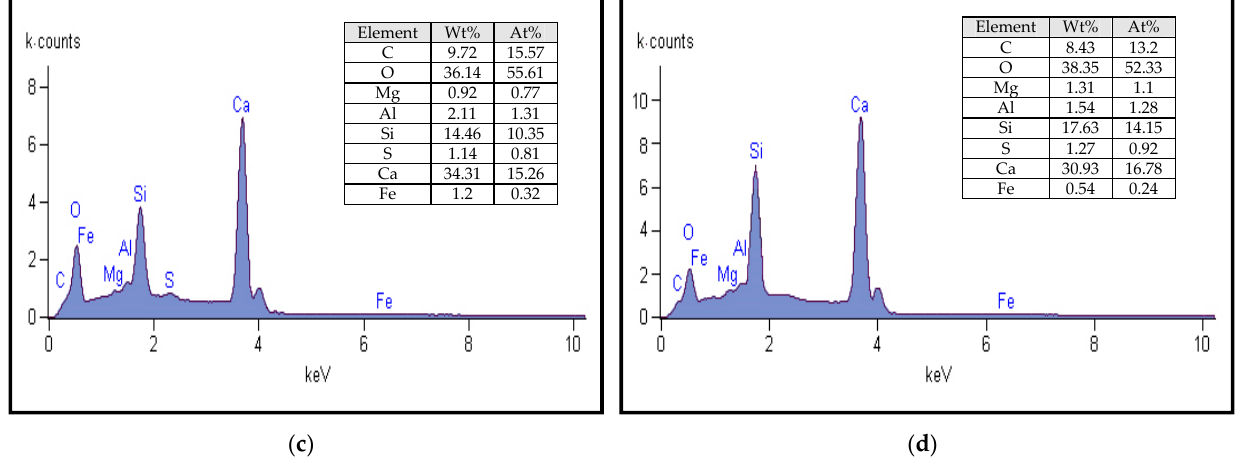
Figure 14. EDX analysis for healing compounds at 28 days for 100%OPC (up) and 95%OPC + 5%SF (down) ( a ) 100%OPC without capsules, ( b ) 100%OPC with capsules, ( c ) 95%OPC + 5%SF without capsule, ( d ) 95%OPC + 5%SF with capsule.